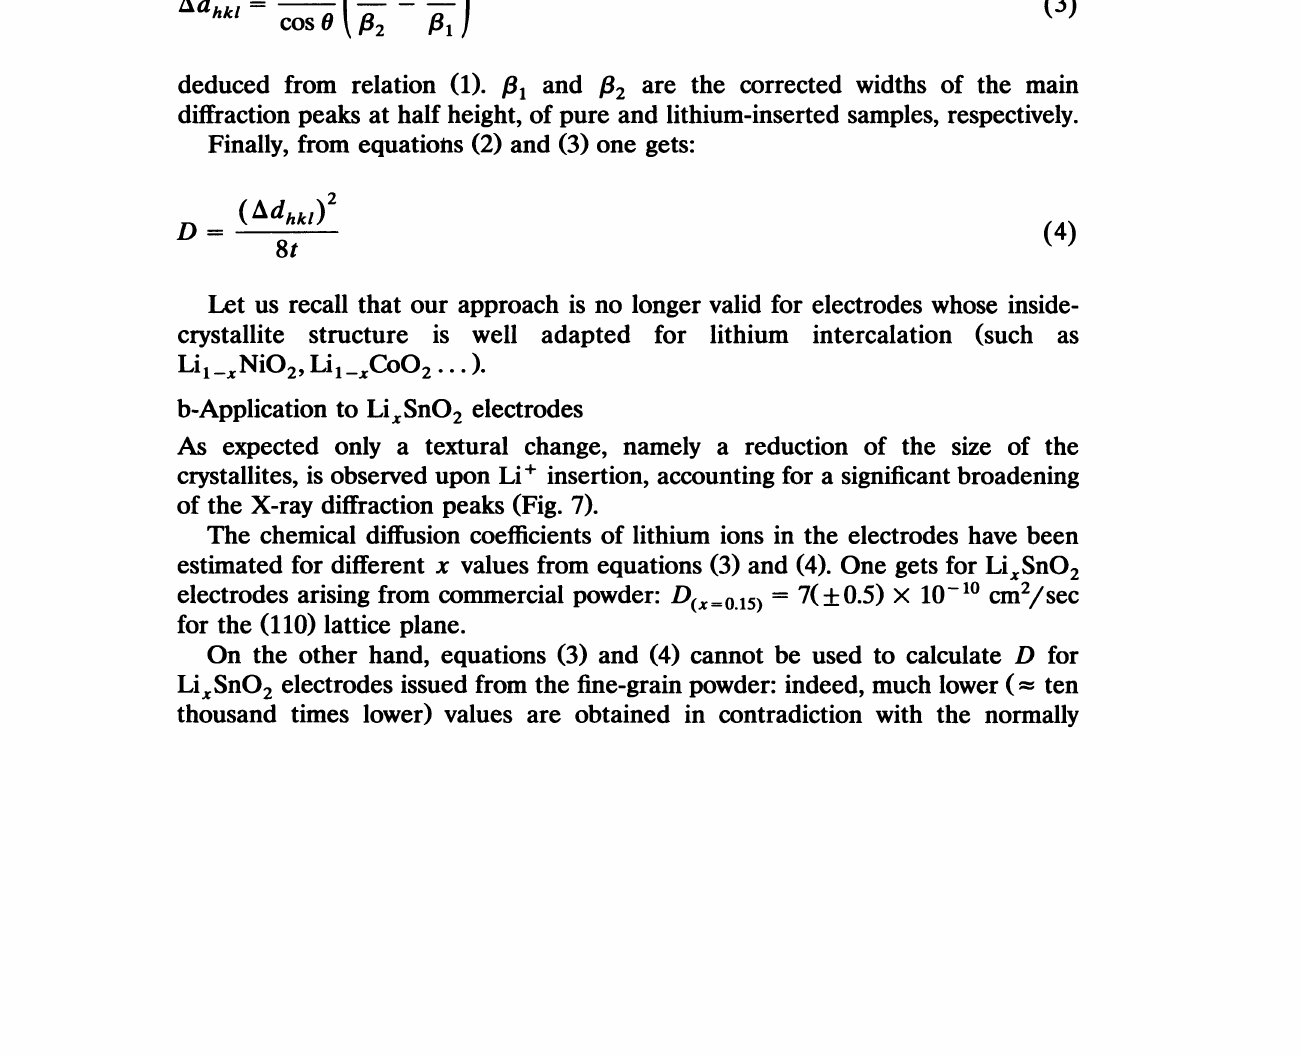
FIGURE 6 Decrease of the size of crystallite upon lithium insertion. (1) well crystallized remaining region of composition SnO_; (2) amorphous region of composition LixSnO insertion. Adhk --d- d where d and di designate respectively the crystallite size of pure and inserted sample. Adhkl 2L can be expressed in the equation: